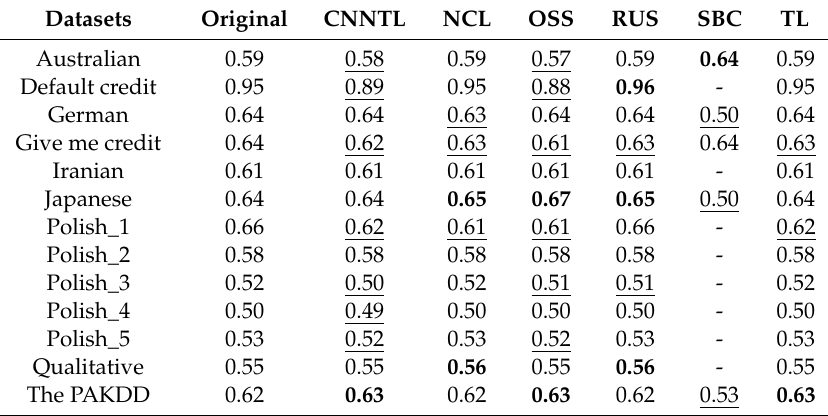
Table 10. AUC for HACT classifier after undersampling algorithms.